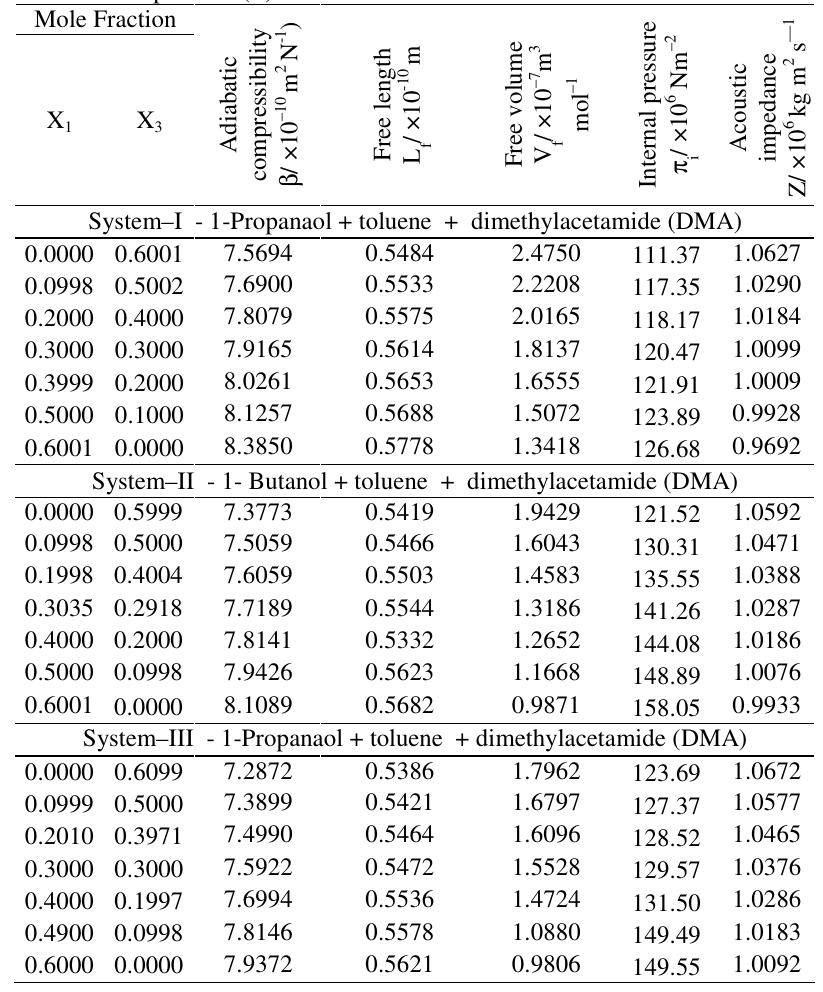
Table 3. Adiabatic compressibility ( β ), free length (L ( π ) and Acoustic impedance i